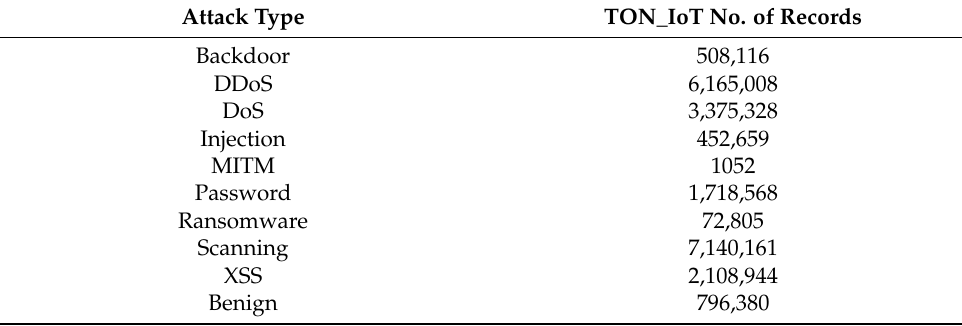
Table 3. TON_IoT attacks